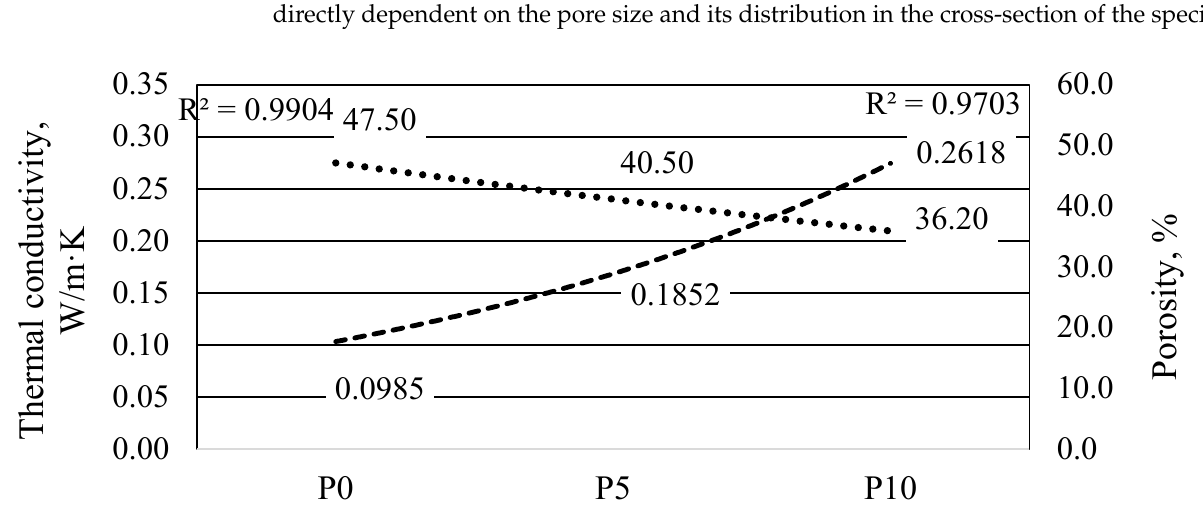
Figure 14. Dependence of the thermal conductivity coefficient and pore percentage of the material on the amount of phosphogypsum in the material mixture.